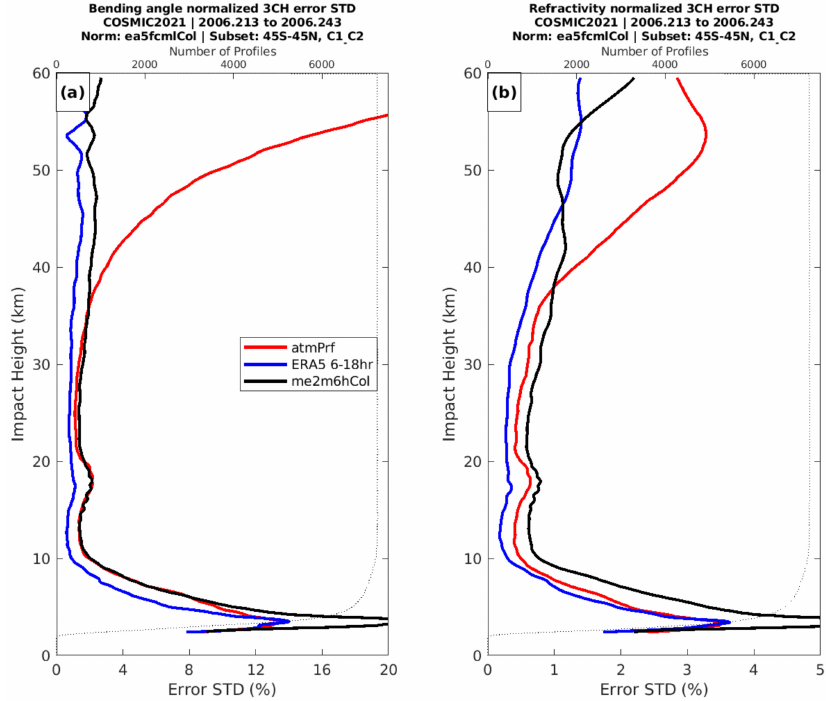
Figure 7. Vertical profiles of error STD (uncertainties) of the bending angle ( a ) and refractivity ( b ) for C1 (atmPrf), ERA5, and MERRA-2 for August